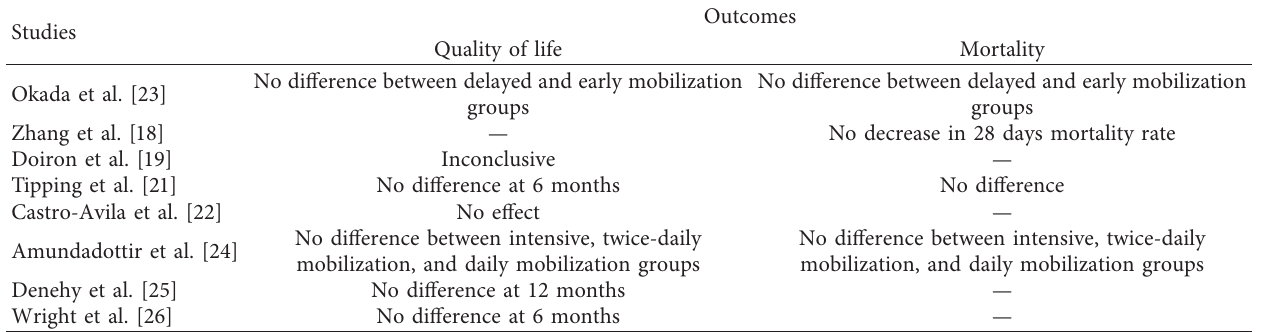
Table 2: Long-term impact of early mobilization on